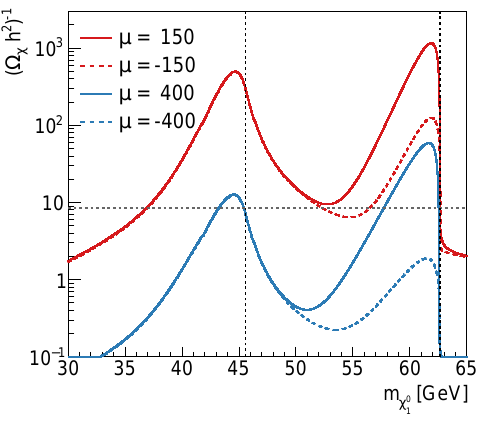
Figure 4: Inverse relic density near the Z -pole and Higgs pole in the